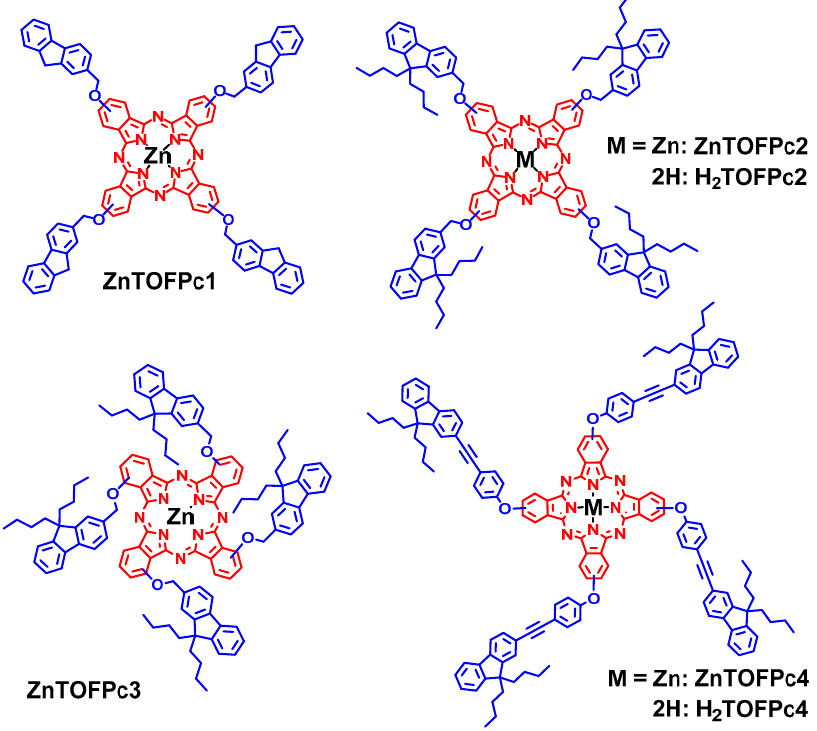
Figure 3. New targeted alkoxy and phenoxy substituted phthalocyanines.